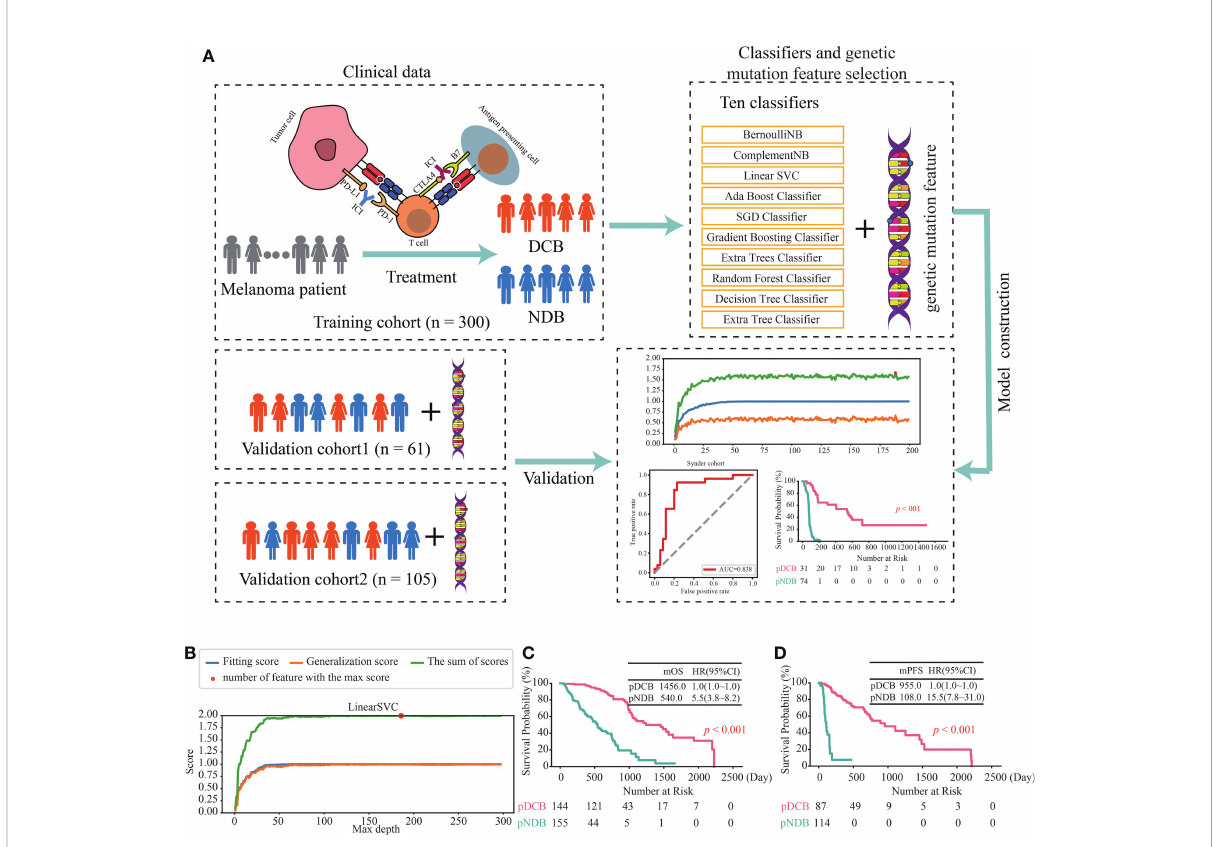
FIGURE 2 Construction of the DCB model for the treatment of ICIs in melanoma. (A) Work fl ow of the study. (B) The line chart of the f1 scores of fi tting and generalization as well as the sum of the scores for Linear SVC in the training cohort. (C, D) Kaplan – Meier curves of OS (C) and PFS (D) comparing pDCB with pNDB from the DCB model in training